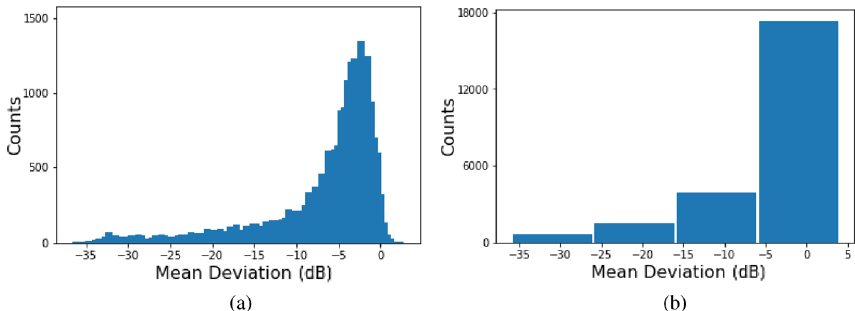
Figure 2. Distribution of the training data: ( a ) The data is characterized by an uneven distribution across different MD values, with a long tail towards the low MD values. ( b ) The bulk of the data has MD values better than − 6 dB. The amount of data progressively diminishes through the other intervals.